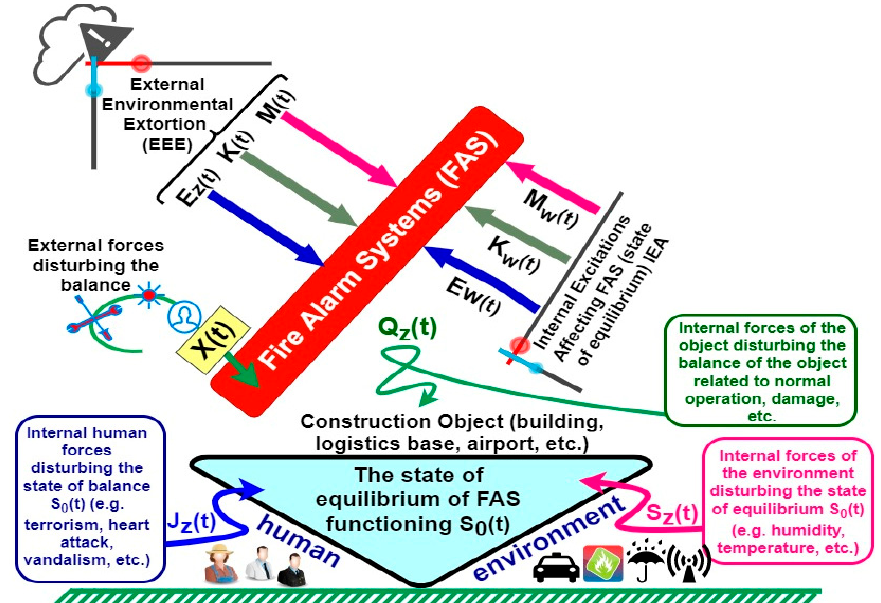
Figure 1. Violation of a safe status of a building due to the impact of external and internal actions on a fire alarm system installed within the building in question. Figure designations: external actions X(t) e.g., theft, robbery (assault), terrorist attack on the structure, deliberate arson, or other external action; E Z (t); E W (t) is electromagnetic interference of the natural electric and magnetic field of the Earth and building surroundings through the use of an unintentional and intentional (stationary and mobile) radiation sources near the building; K(t) external climate (environmental) conditions, K w (t) internal climate (environmental) conditions, M(t) external mechanical environmental interference (e.g., vibrations of the ground, walls, air, etc.), M w (t) internal mechanical environmental interference (e.g., vibrations of the walls, partitions, windows, etc.), S 0 (t) state of safety equilibrium ensured by a fire alarm system associated with the balance of three interacting adverse sequences: external Q Z (t) and internal sequences (processes) associated with facility operation: people staying in the facility (permanent residence, customers visiting given rooms) is Z (t), changes in the internal publicly available environment S Z (t) for the operated structure.